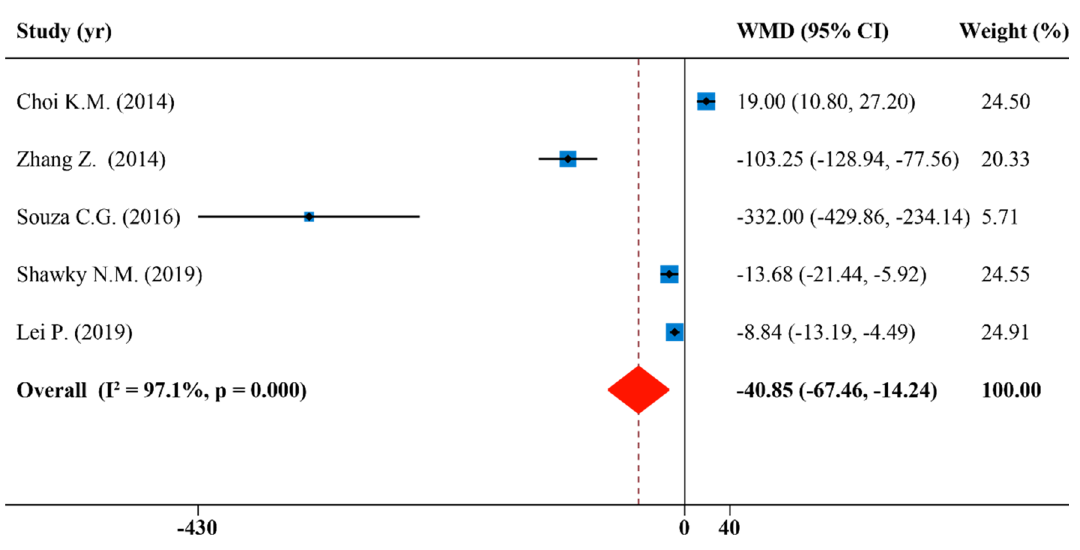
Figure 7. Forest plot showing effects of SFN on serum